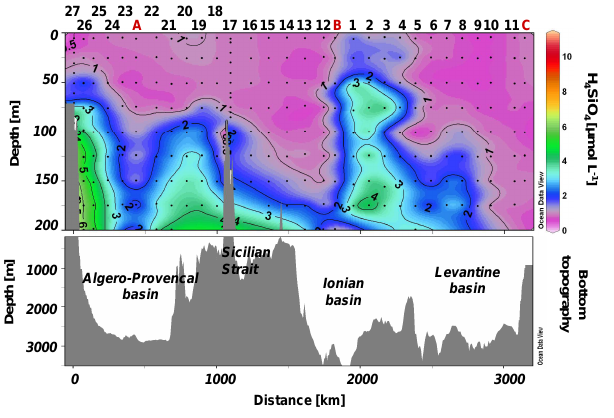
Fig. 4. Orthosilicic acid distribution (µM) during the BOUM cruise (late summer 2008).